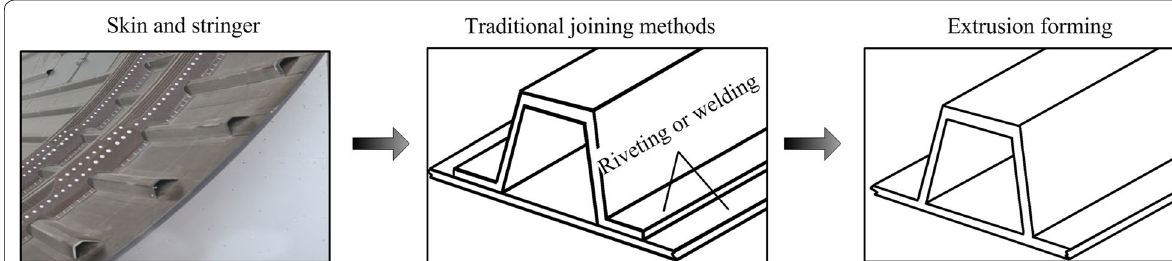
Figure 10 Integrated extrusion process substituting for the riveting and welding